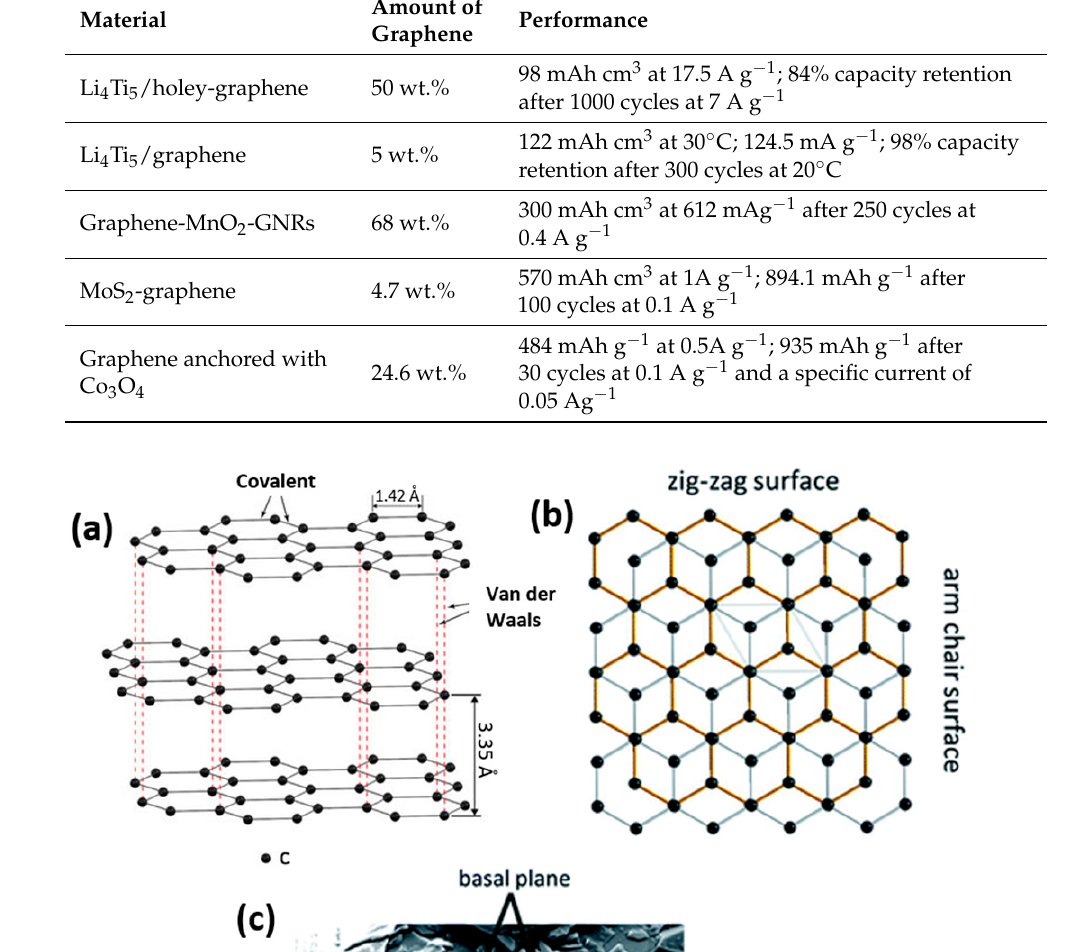
graphite intercalation compounds (GICs), typically LiC6. GICs possess high reactivity and sensitivity to oxygen and moisture, resulting in rapid material degradation. Table 2. Performance of LIBs with graphene-based anode materials. Material